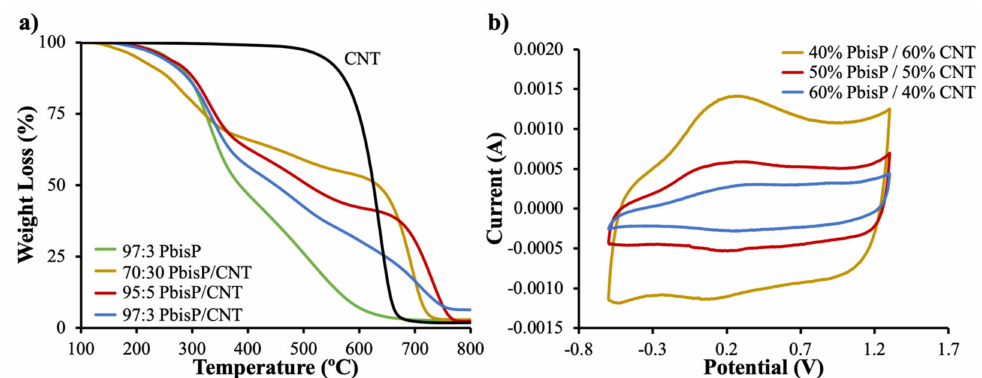
Figure 6. ( a ) Thermogravimetric analyses (TGA) of the different copolymers obtained by electropoly- merization and its comparative with control samples ( b ) CVs of the materials carried out at 50 mV/s in acetonitrile and TBAPF 6